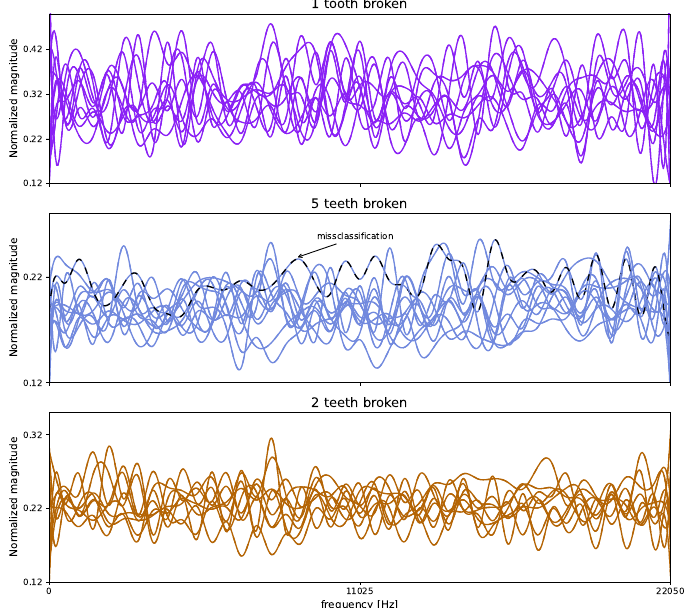
Figure 11. Multiclass classified validation subset. The graph shows predicted classes for all samples. Missclassification is highlighted by black dashed lines. The Y axis ranges are varied to better show the results and